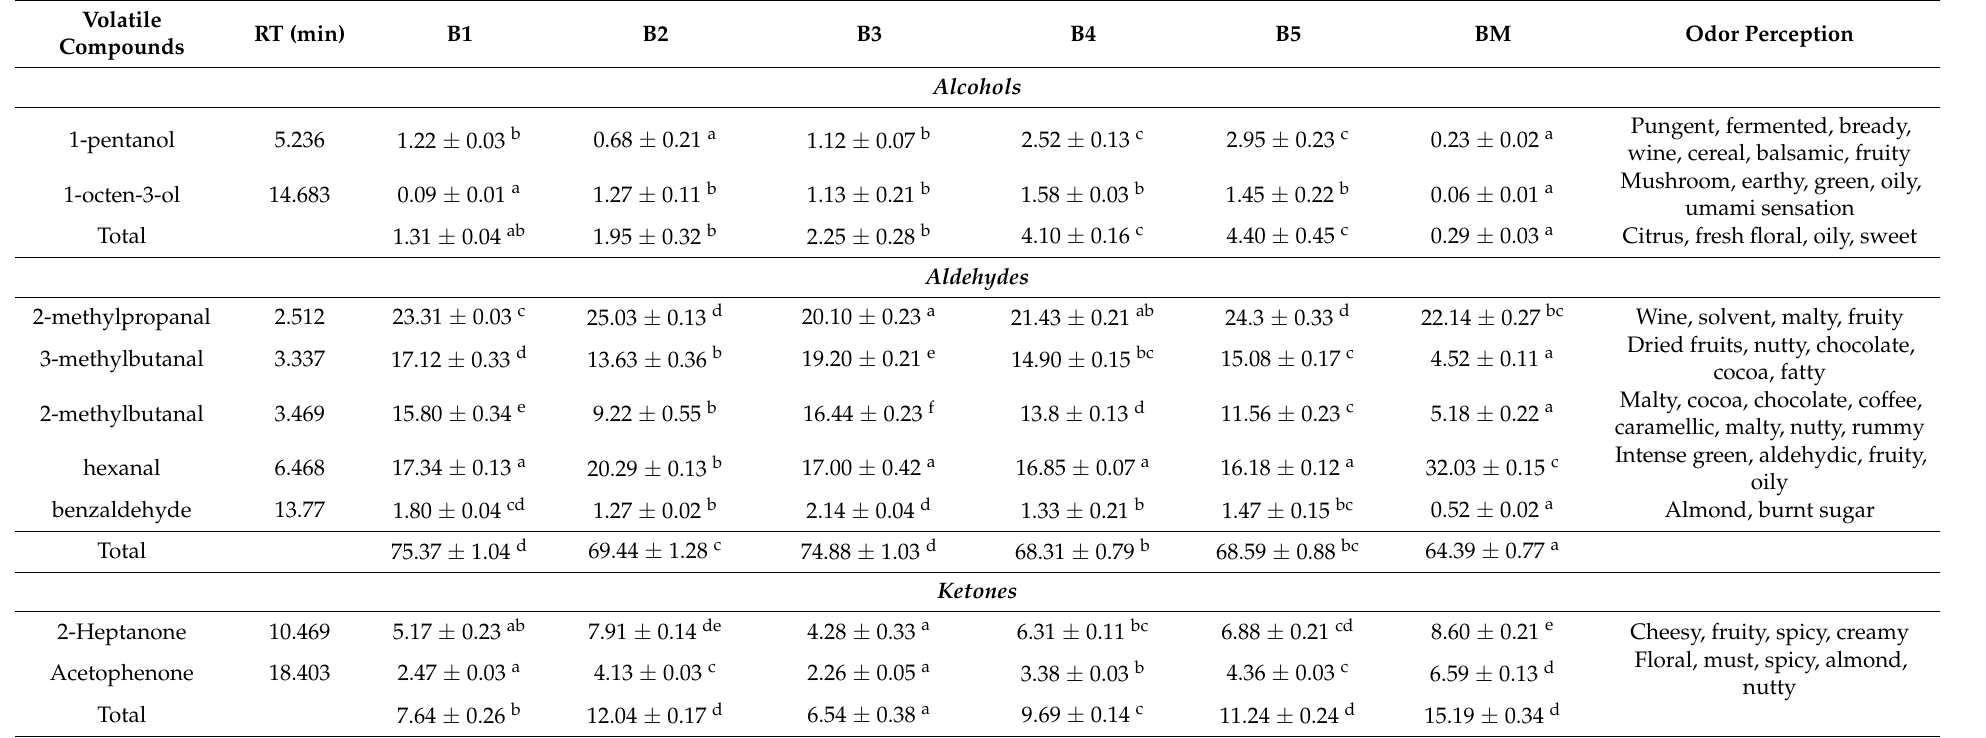
Table 7. Volatile aroma compounds of the final baked goods expressed as arbitrary units (a.u.) from the relative peak